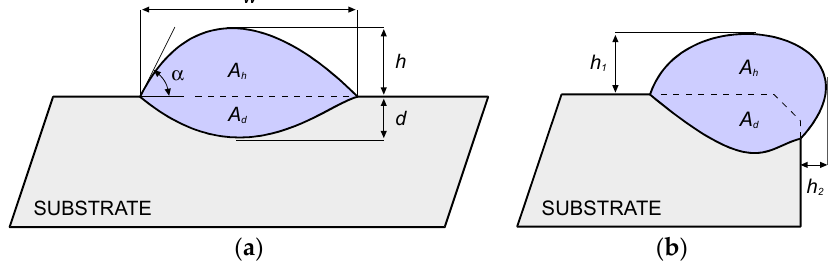
Figure 4. Scheme of the cross-section resulting from deposition ( a ) over flat surface and ( b ) edge.